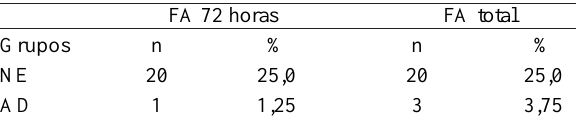
FA = fibrilação atrial; NE = grupo não estimulado; AD = grupo submetido a estimulação atrial